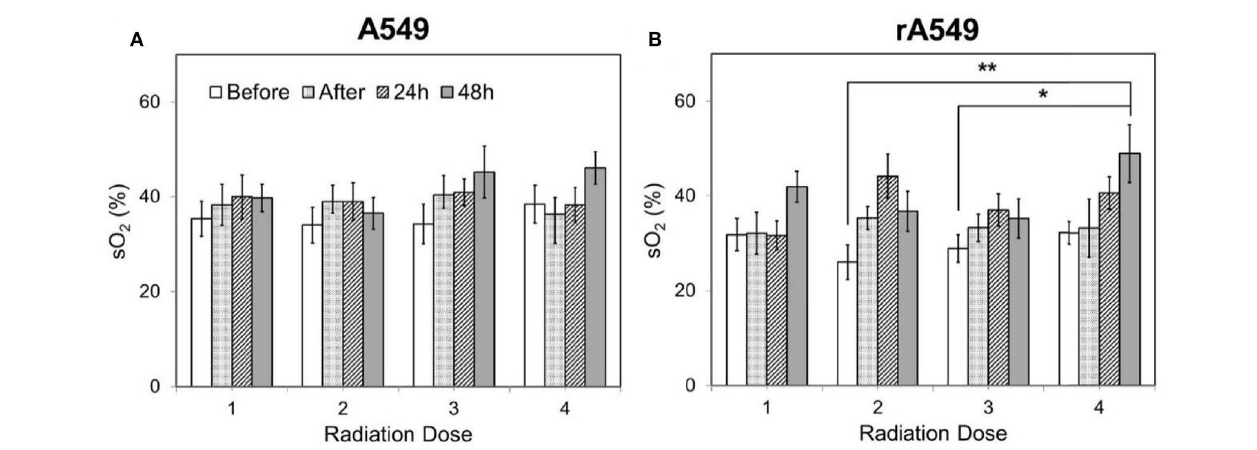
FIGURE 4 | Changes in vascular oxygen saturation across all four doses of radiation for radiation-sensitive (A) and resistant tumors (B) . Each radiation dose presents the mean sO 2 value for the following time points: 0h, immediately after, 24 and 48h post radiation. Data shown as mean ± SEM. *indicates p < 0.05 and ** p < 0.01. Adapted with permission from Diaz et al. (